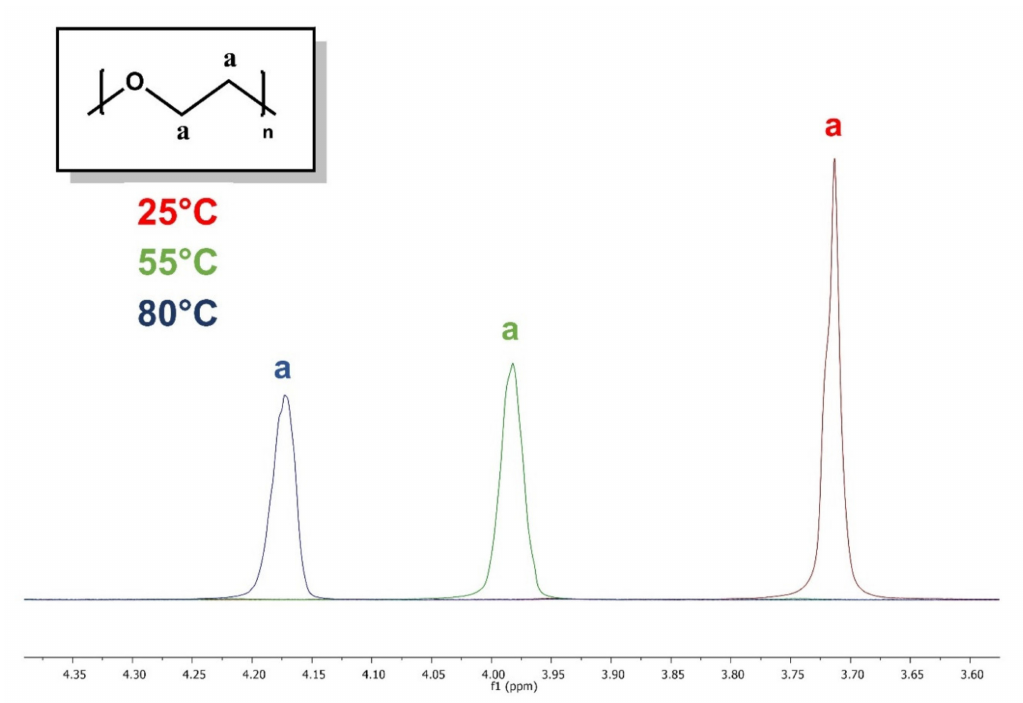
Figure 11. Comparison of 1 H-NMR spectra of PEO homopolymer at various temperatures, where the red, green, and blue letter (a) refers to the protons of PEO homopolymer at 25 ◦ C, 55 ◦ C and 80 ◦ C, respectively.